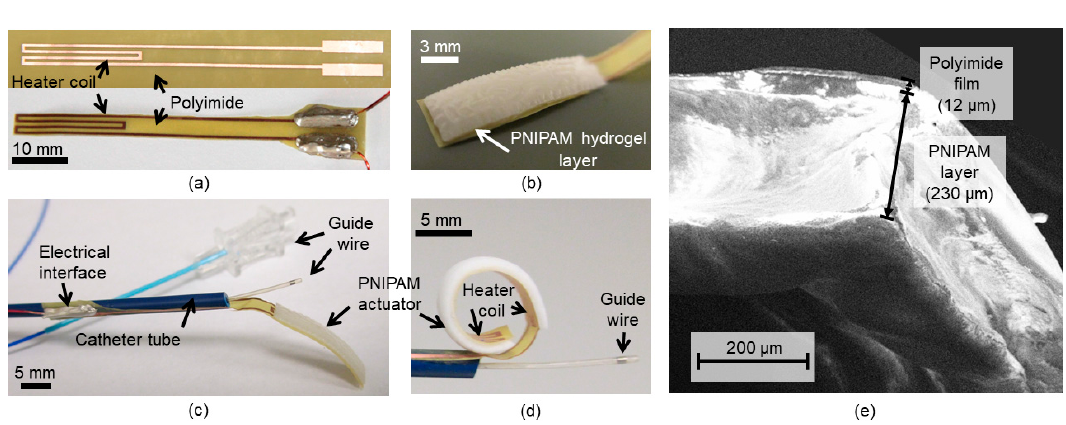
Figure 3. Process steps developed for the fabrication of the active catheter tip device.